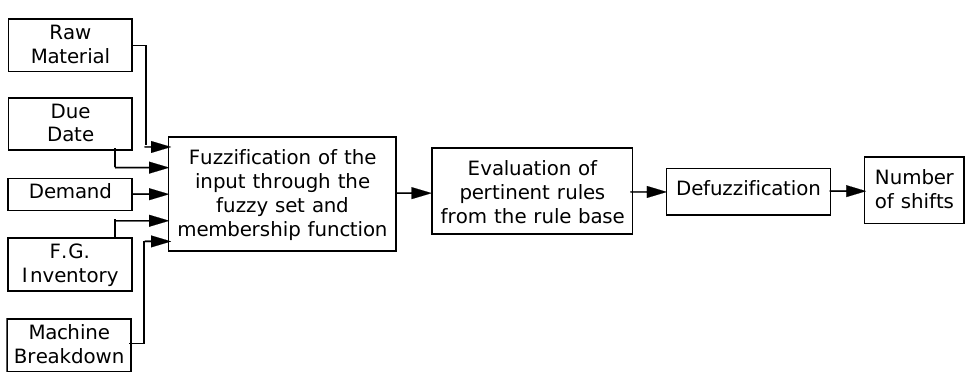
Figure 2. “Fuzzy Model of proposed system”. Source: Own contribution